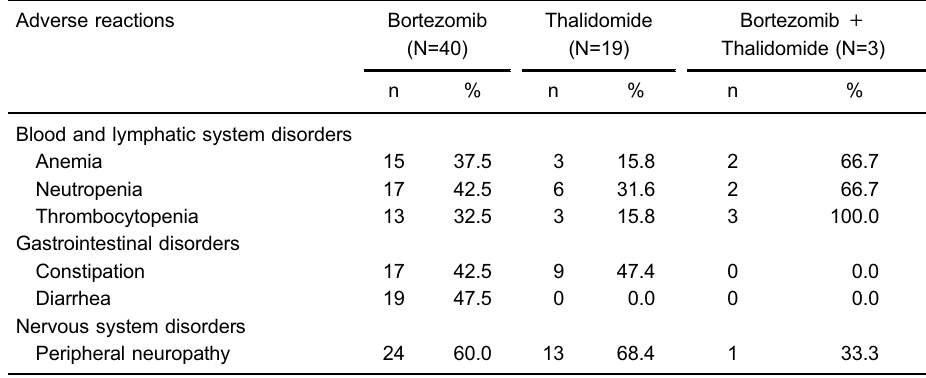
Table 4. Main adverse reactions in multiple myeloma patients, according to their treatment